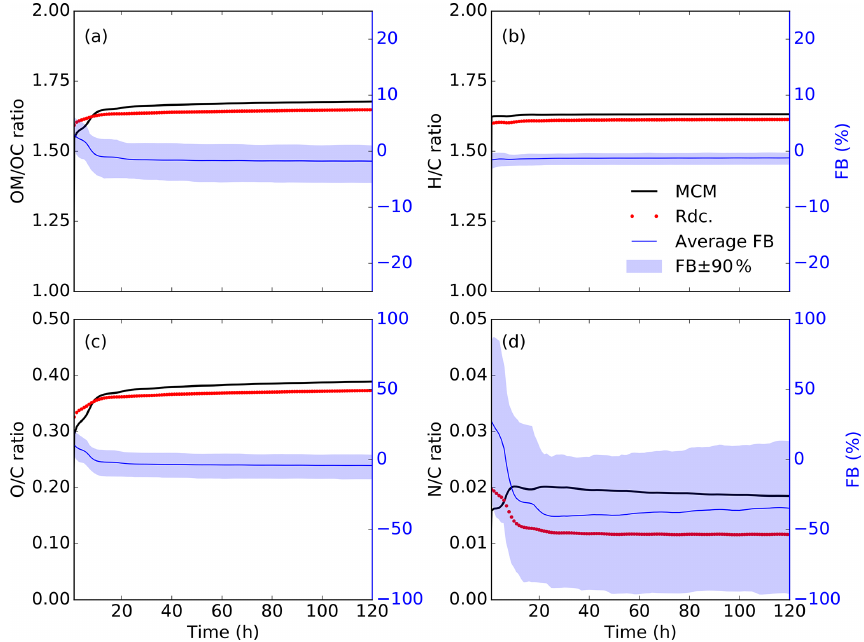
Figure 10. Temporal variations in the (a) average organic mass to organic carbon mass (OM / OC) ratio, (b) hydrogen to carbon (H / C) atomic ratio, (c) oxygen to carbon (O / C) atomic ratio, and (d) nitrogen to carbon (N / C) atomic ratio, simulated with MCM (solid black curves) and the Rdc. mechanism (dotted red curves) on the pre-testing dataset. The average FB (solid blue line) and the 90% range of the FB (blue shading) are also presented.